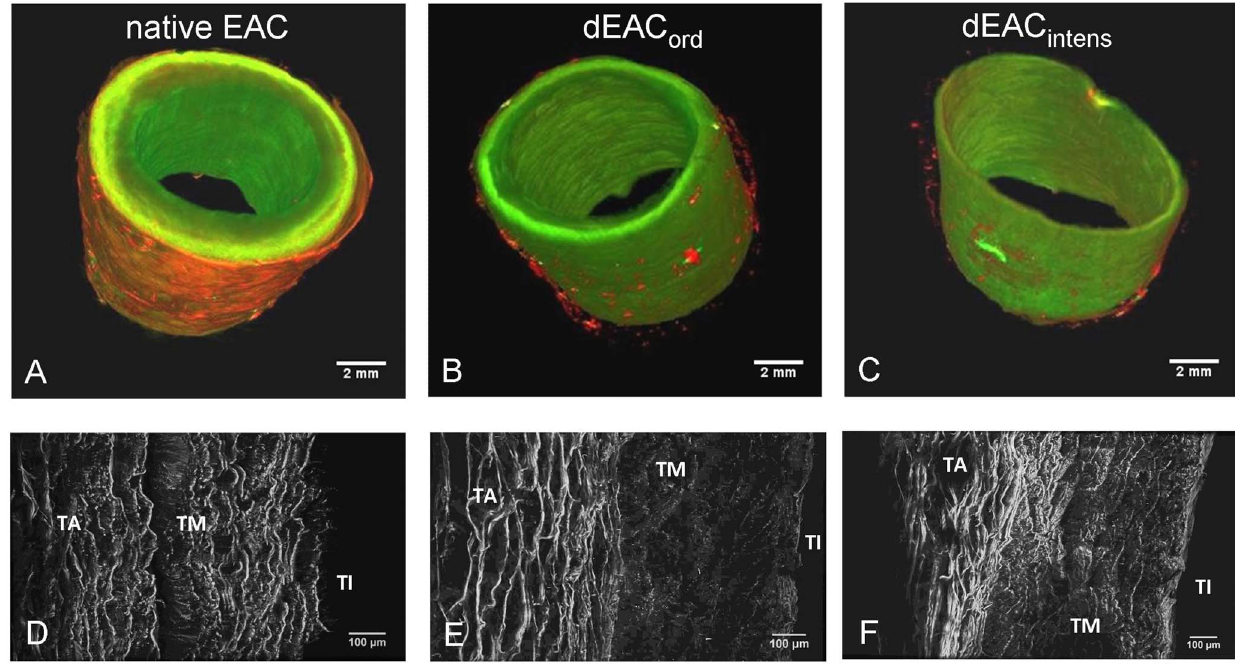
Figure 2. Correlative volumetric visualization of the carotid wall for native EAC, dEAC ord and dEAC intens by Scanning Laser Optical Tomography (SLOT). SLOT (A–C) was performed in transmission mode displaying autofluorescence at 532 nm on tissue pieces of 1.5 cm in length from the indicated tissues and by Multi Photon Microscopy (D–F) with maximum intensity projections of axial cross sections of the indicated tissues representing the autofluorescence at 800 nm excitation wavelength. TA: tunica adventitia; TM: tunica media; TI: tunica intima.